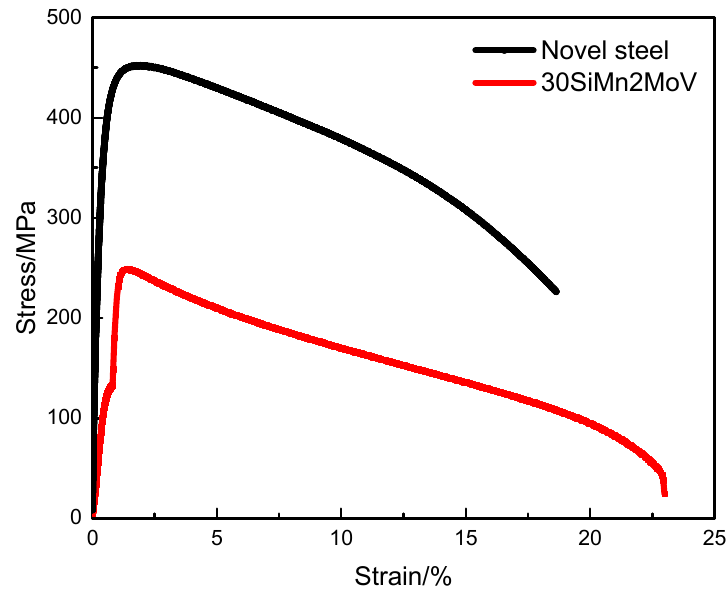
Figure 4. Monotonic tensile stress-strain curves of the novel steel and 30SiMn2MoV steel at 700 °C.